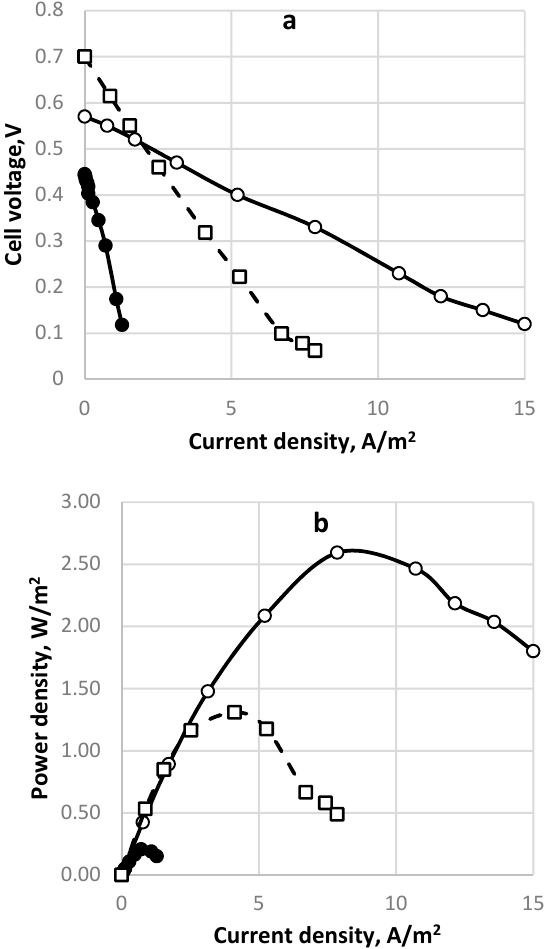
Figure 7. Polarization curves for three different inlet sulfide concentrations. Membrane Celgard 3501 with 7 sq. cm membrane area. Feed flow rate 0.2 dm 3 /h. Symbols: ( • ), solid line—70 mg dm − 3 ; ( ο ), solid line—240 mg dm − 3 ; ( ), dashed line—1100 mg dm − 3 . Supporting electrolyte—16 mg dm − 3 NaCl. Anode space volume—800 cm 3 . ( a ) Polarization curve; ( b ) power density vs. current density. ▯